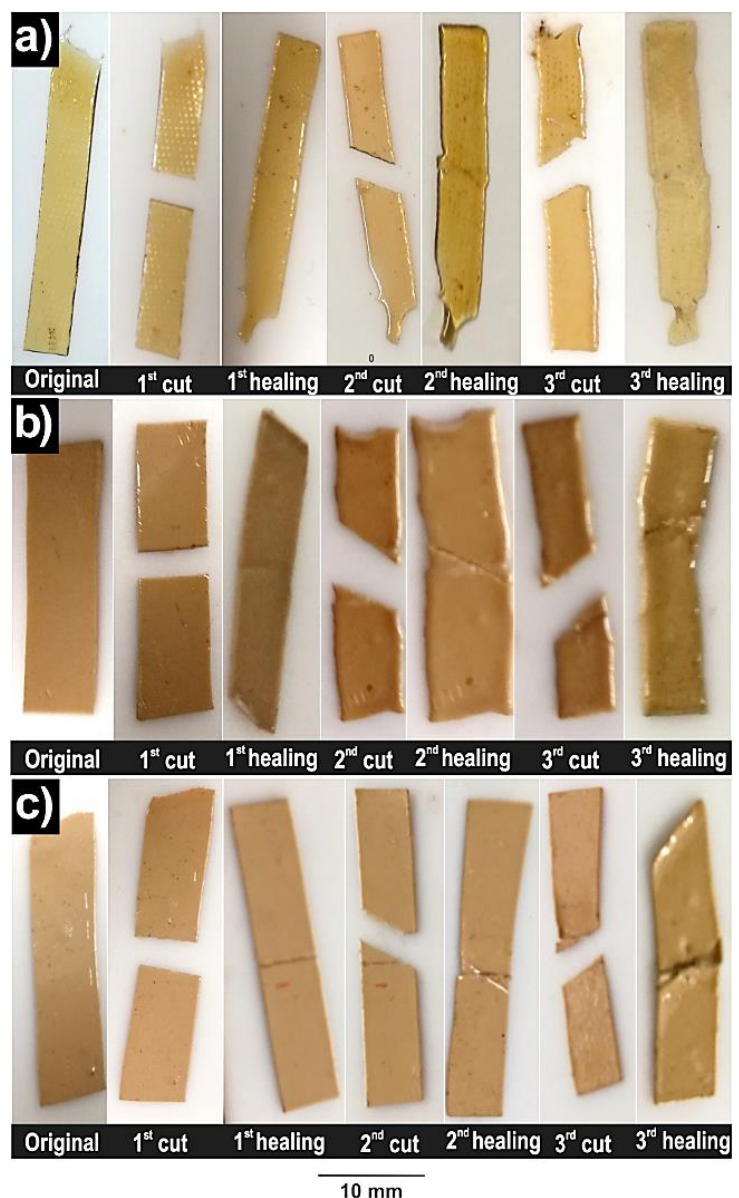
Figure 5. Visual self-healing process of ( a ) PU0, ( b ) 10TiO 2 -PU0 and ( c ) 20TiO 2 -PU0.